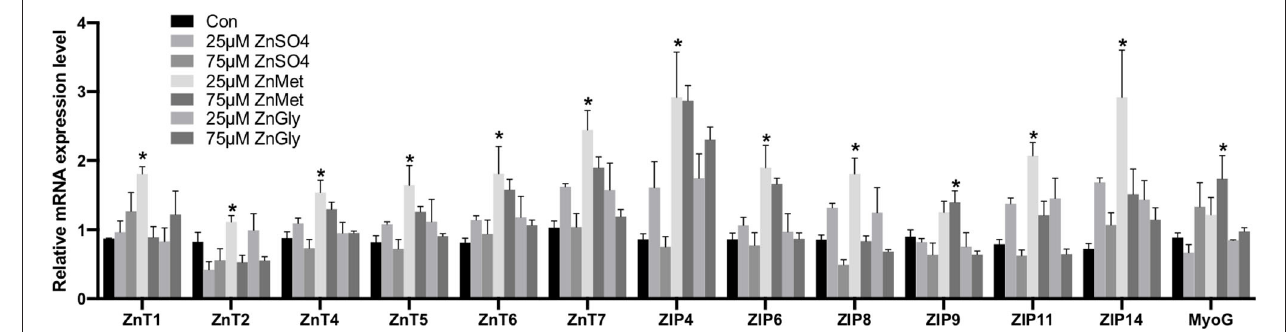
FIGURE 3 | The mRNA expression levels of the key genes of C2C12 cells by adding different zinc sources. The * above the bar indicates the significant difference ( P < 0.05) among different treatments, n = 9.